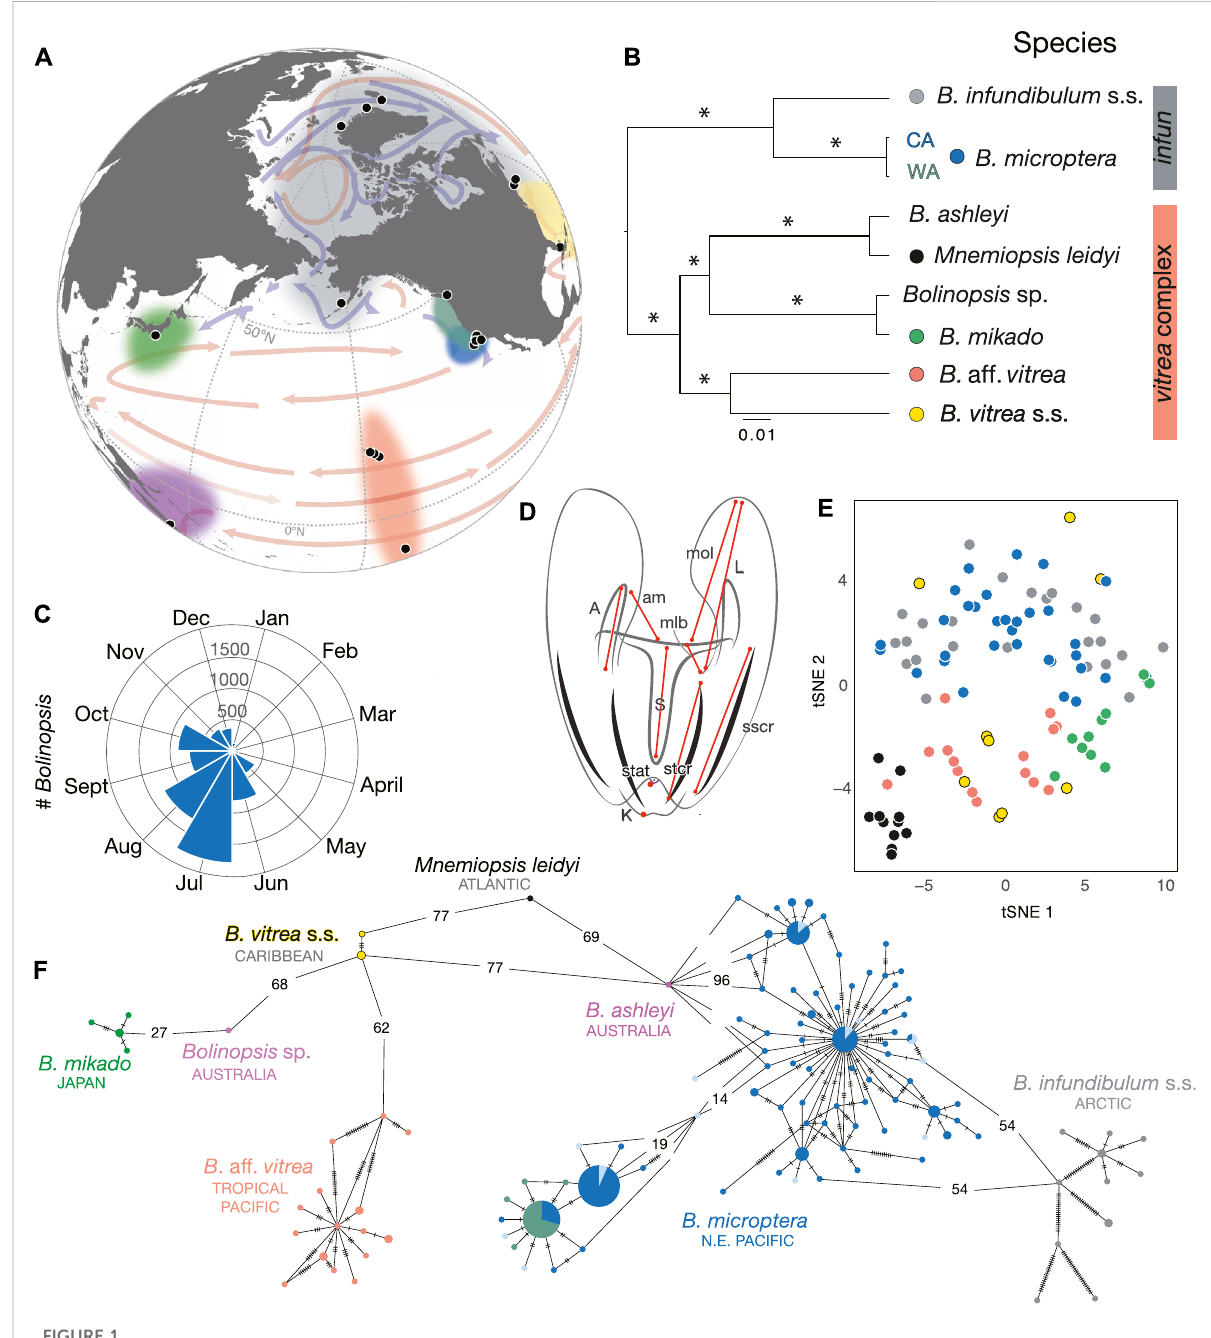
FIGURE 1 (A) Worldwidesamplinglocalitiesforspecimenssequencedfromthegenera Bolinopsis and Mnemiopsis, speciesdesignatedbycolorsatnodes of species tree (B) . (B) Species tree estimated with the GTR + I+ Γ for Bolinopsis species + M. leidyi with fragments of COI (648 bp) , H3 (352 bp) , and 28S (996 bp) including B. infundibulum (gray bar) and B. vitrea (coral bar) species complexes. * indicates 1.0 posterior probability. (C) Seasonal distribution of California Bolinopsis , visualized by ROV videos at MBARI by midwater research groups. (D) Illustration of Bolinopsis showing landmarksusedintSNEanalysisincludingauricle(A)andlobe(L)lengths,thedistancesfromthemouthtotheorallobe(mol),mouthtothelobebase (mlb),keel(K),statocyst(stat),theauricletiptothemouth(am),andthelengthsofthesub-tentacularctenerow(stcr)andsub-stomodaealctenerow (sscr), all of which were normalized by the length of the stomodaeum (S). (E) tSNE plot of combined morphological measurements designated in (D) of M.leidyi and Bolinopsis species, colorscorrespondto speciesin (B) and (F) . (F) Correspondingminimumspanningnetwork of259individuals fora 648 bp fragment of mitochondrial COI. Dashes or numbers on branches represent